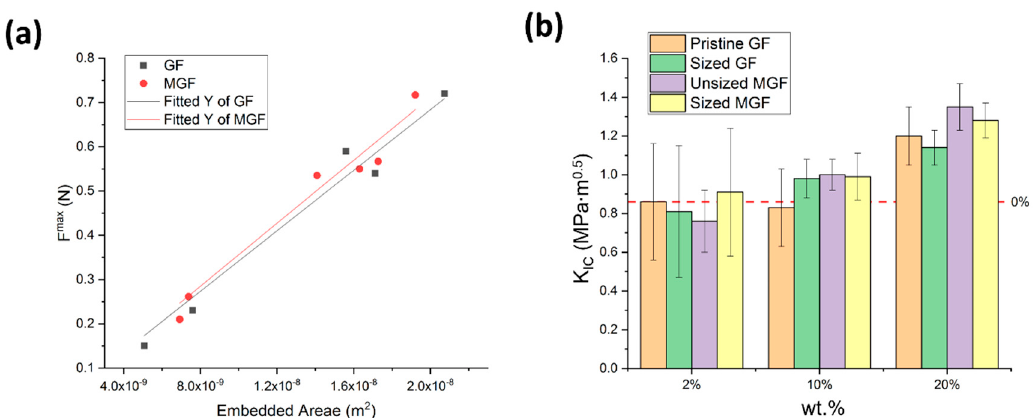
Figure 7. E ff ect of interface. ( a ) The maximum force required during the test is plotted as a function of the embedded surface area of the fiber, for glass fiber (GF) and magnetized glass fiber (MGF). ( b ) Fracture toughness of epoxy composites reinforced by glass fibers with di ff erent interfacial coating and three weight fractions. No magnetic field was applied, and the fibers were uniformly distributed and randomly oriented.